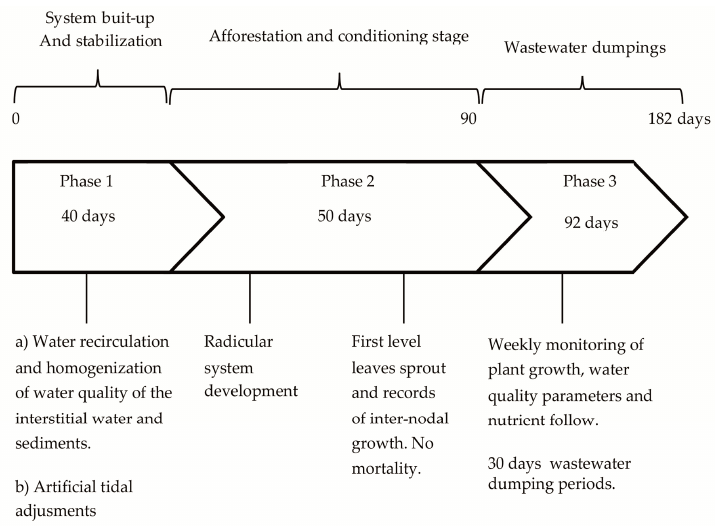
Figure 2. Experiment timeline events.